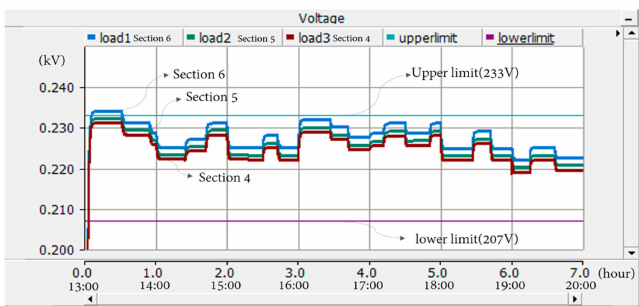
Figure 17. Analysis of the customer voltage characteristic by SVR operation (upper limit).